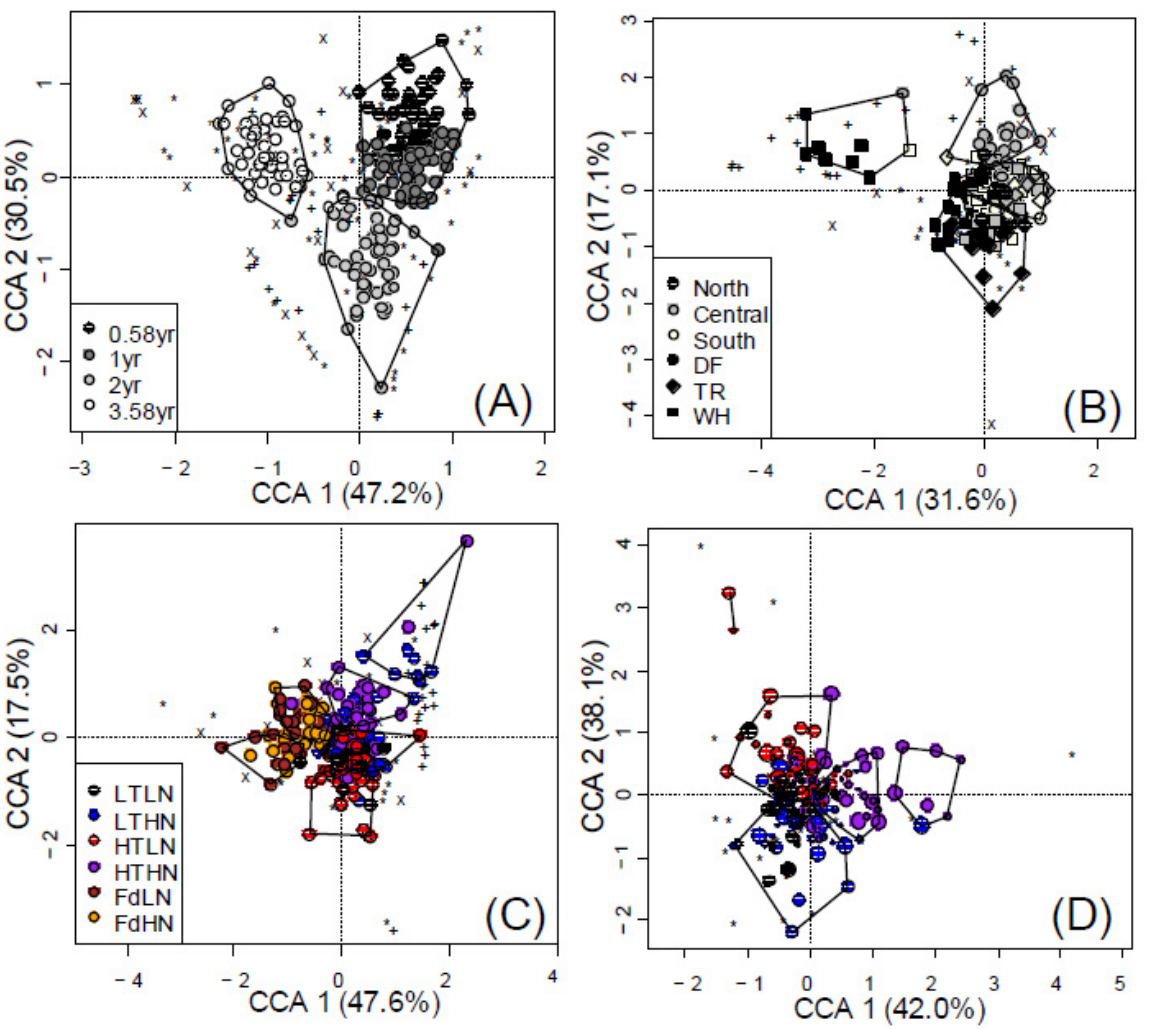
Figure 3. Partially constrained CCA showing the effects of ( A ) time, ( B ) site and ( C ) CT level on microbial composition of fungi (*), NifH (+) and AmoA (X) communities associated with poplar and Douglas-fir (Fd) leaf litter with low and high nitrogen (LN and HN) and condensed tannin (LT and HT, poplar only) content and after 7, 12, 24 and 43 months of decay. Litter chemistry effects on ( D ) fungi communities associated with poplar litter only, where point size decreases with time. Polygons represent k-means clustering based on CCAs 1 and 2.